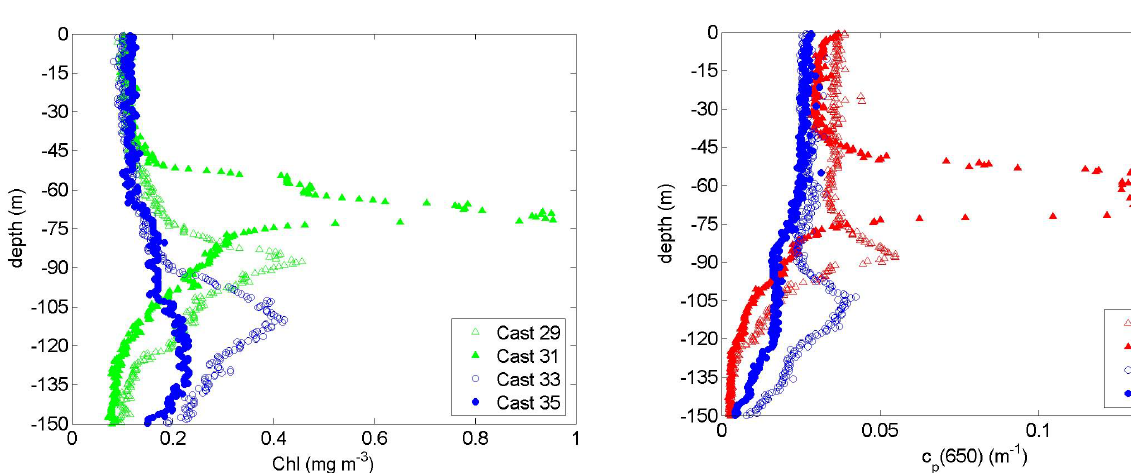
Fig. 5. Vertical profiles of chlorophyll concentration for the four casts.